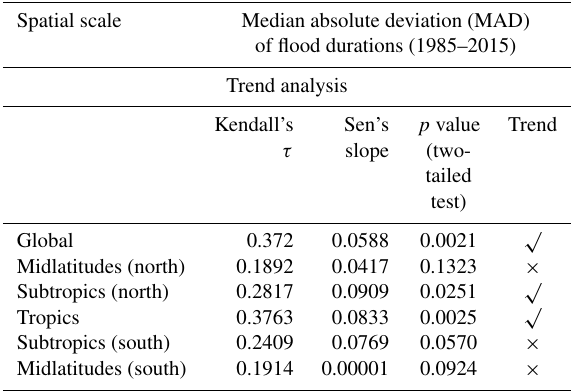
Table 4. Same as Table 2 but for the median absolute devia- tion (MAD) of flood